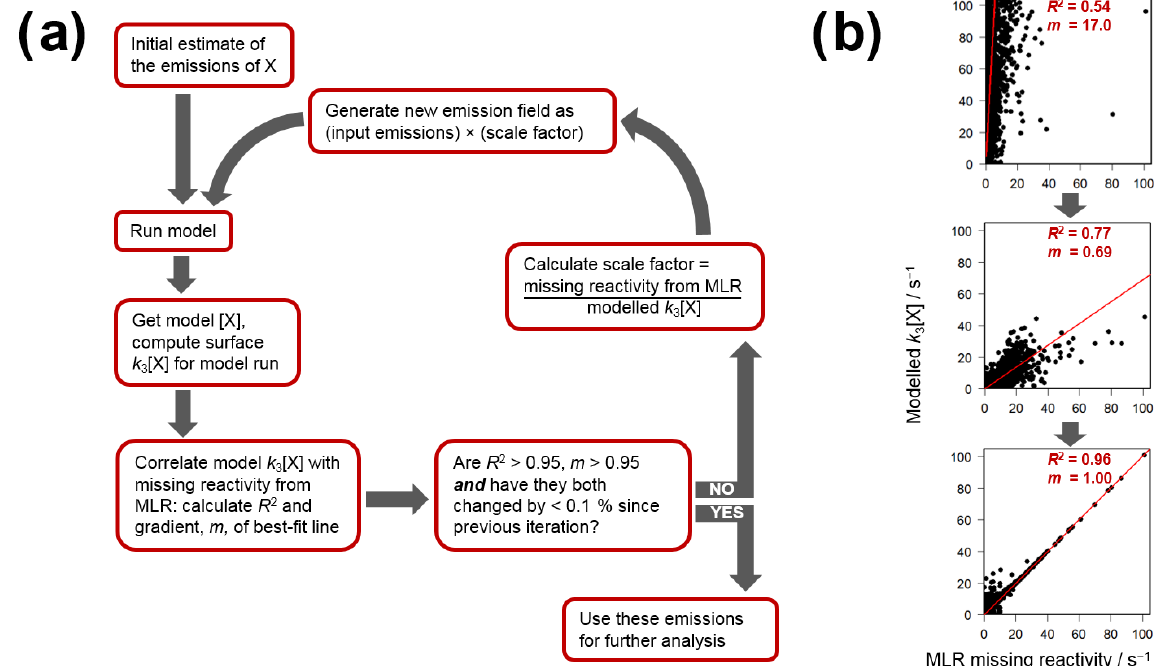
Figure 6. Implementation of the routine used to convert the global missing reactivity field obtained from multiple linear regression (MLR) into emissions of species X. Panel (a) illustrates the procedure as a flow chart, whilst panel (b) shows the correlation plots between modelled k 3 [X] and the MLR missing reactivity from non-consecutive iterations. As the R 2 values and the gradients of the correlation plots converge to 1, the emissions of X in the model lead to X-reactivities identical to the missing reactivity derived by